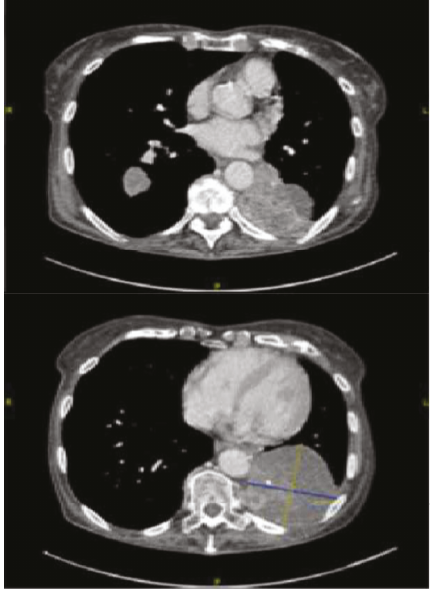
Figure 3: Restaging CT post 15 cycles of Nivolumab. Image on the top shows some reduction in RLL mass and the image on the bottom shows that the LLL mass had increased signi fi cantly.